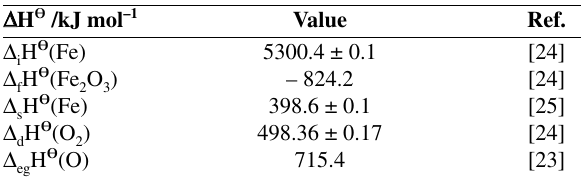
Table 2. Standard enthalpy changes of iron and oxygen ΔΔ H θ /kJ mol –1 Ref.